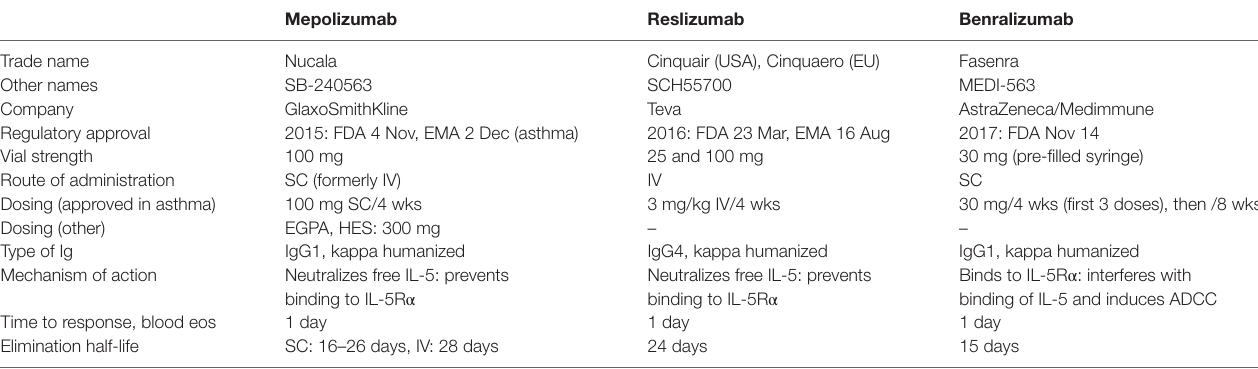
TABLe 1 | Antibodies targeting IL-5 and its